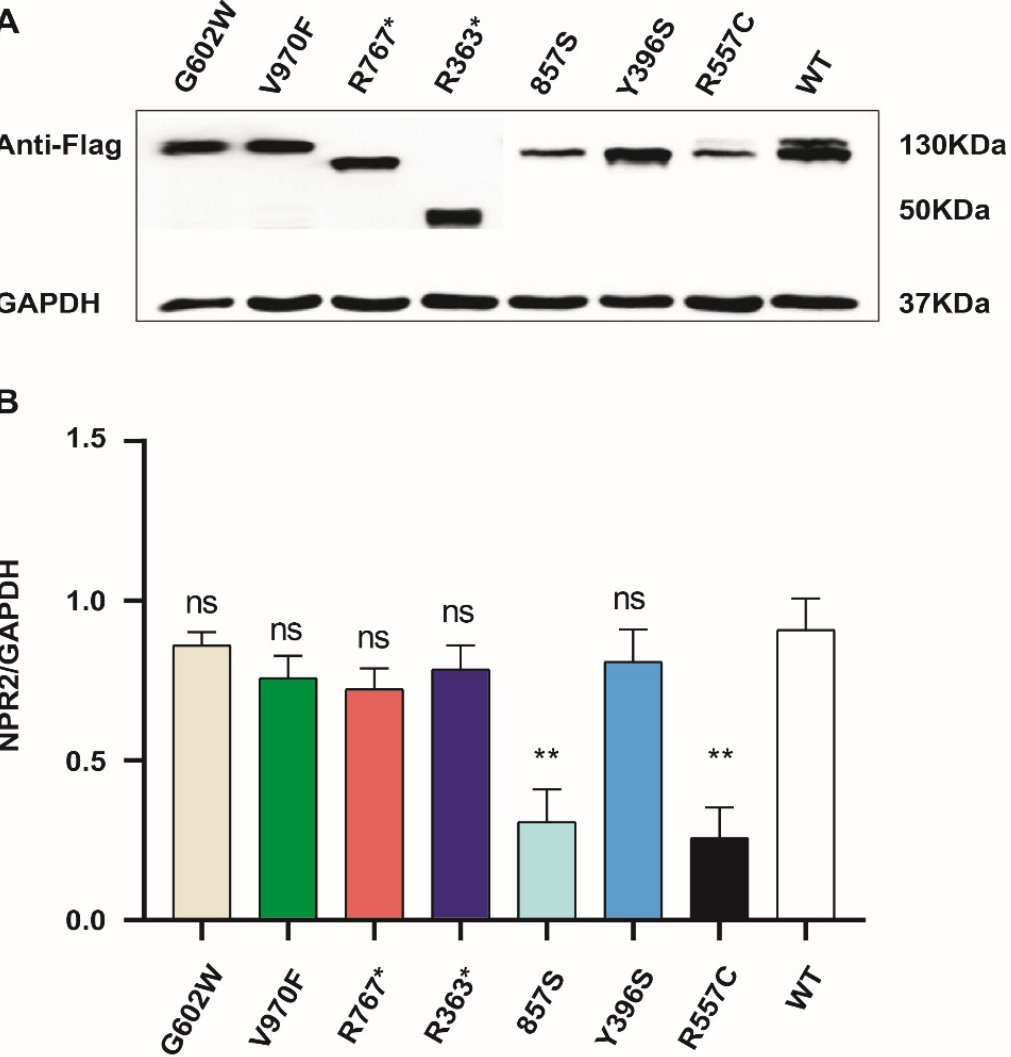
Figure 4. The expression of mutant and wild-type NPR2 gene in HEK293T cell lines. ( A ) HEK293T cells were transfected with NPR2 MUT and NPR2 WT for 36 h. The expression of NPR2 MUT/WT protein is analyzed by Western blot. NPR2 WT and NPR2 R557C typically migrate as two bands in sodium dodecyl sulfate–polyacrylamide gel electrophoresis, while other mutants migrate as only one band. Lanes 3 and 4 indicate the truncated protein. ( B ) Each NPR2 MUT and NPR2 WT band intensity was quantified using Image J software. The graph displays average expression of protein from three independent experiments (wild-type or mutants).** p < 0.01; ns—no significance.